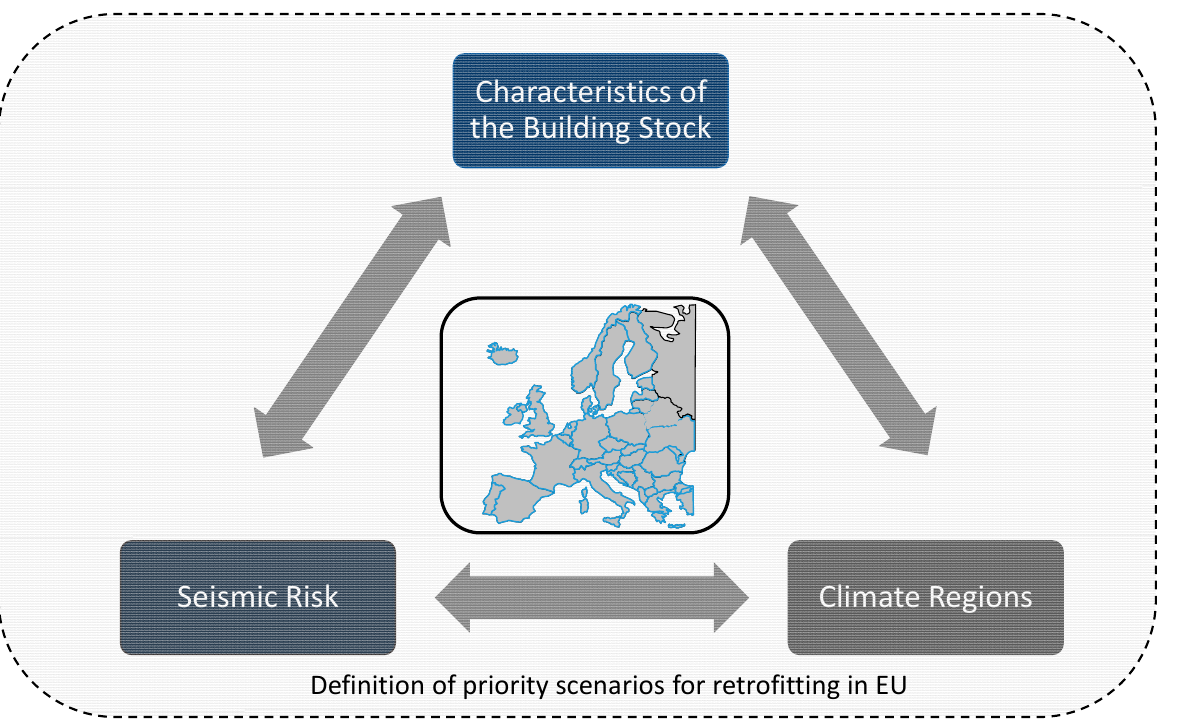
Figure 1. Flowchart of the identification process of scenarios for retrofitting interventions in the EU.